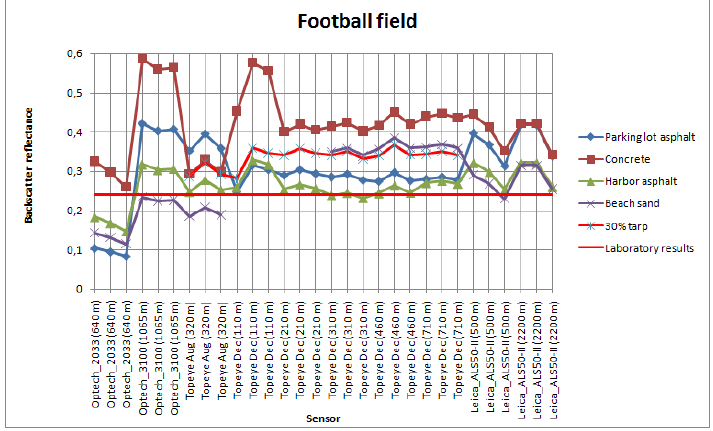
Figure. 7E. Backscatter reflectances of the football field sample calibrated with different samples as reference.